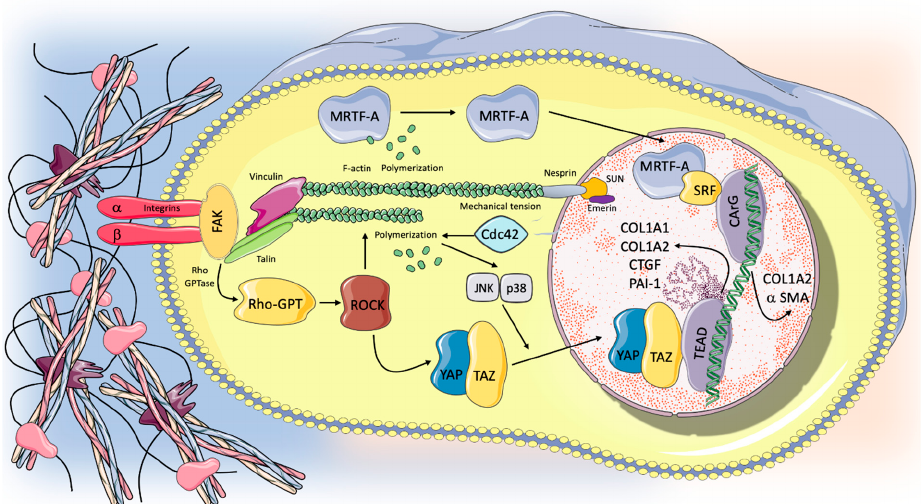
Figure 2. Mechanotransduction and intracellular pathways potentially involved in pulmonary fibrosis progression. Un- physiological mechanical stimuli act on the ECM, which in turn transmitted the physical force to integrins at the cells’ surface. Integrin clustering, through mechanosensitive focal adhesion proteins (i.e., FAK, talin, vinculin), promotes actin polymerization and cytoskeletal remodeling that can transmit forces across the nuclear envelope through specialized proteins (Nespirn, SUN, emerin), potentially influencing gene transcription. Furthermore, different intracellular pathways implicated in the induction of pulmonary fibrosis could be activated via mechanotransduction process. Rho through its effector ROCK acts as a trigger for the activity and nuclear localization of MRTF and YAP-TAZ, which in turn activated the transcriptions of profibrotic genes (COL1A1, COL1A2, CTGF, PAI-1, a SMA). Cdc-42, a GTPase protein that is part of the Rho family, is involved in alveolar regeneration after it increased mechanical tension in response to lung injury via JNK/p38 activation and nuclear YAP expression in AT2 cells. Therefore, the loss of Cdc-42 function could result in a dysfunction in alveolar renewal after lung damage. For further details, see the